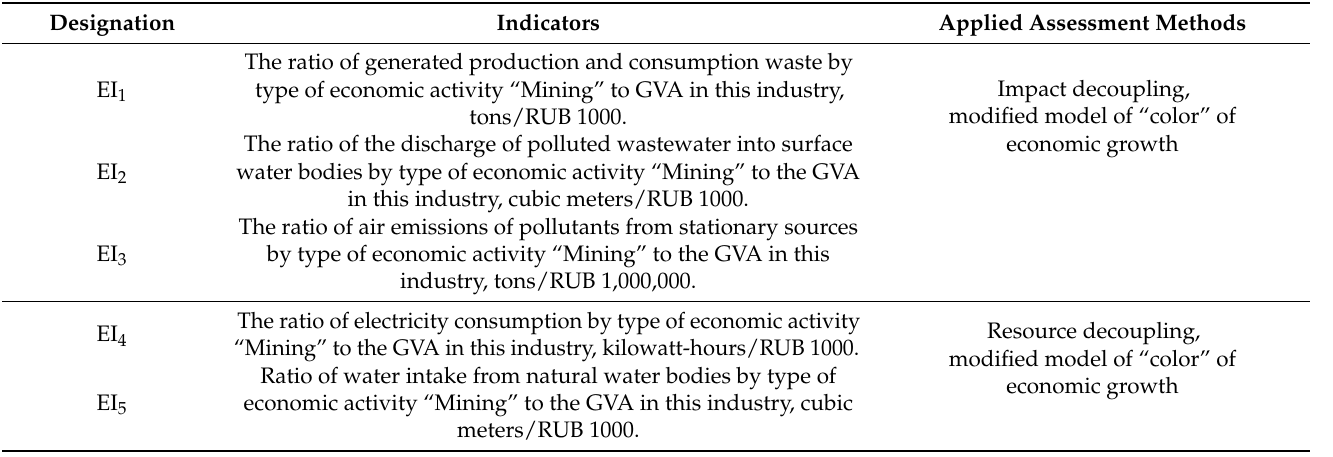
Table 2. Specific indicators of the eco-intensity of the mining